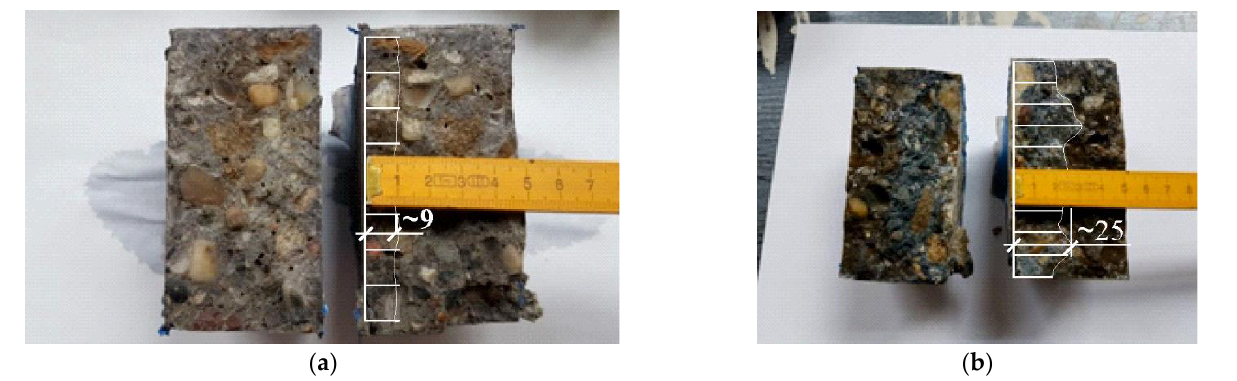
Figure 4. Chloride penetration depth x d = 9 mm-C6 concrete ( a ); x d = 25 mm-C7 concrete determined by the colorimetric method ( b ).